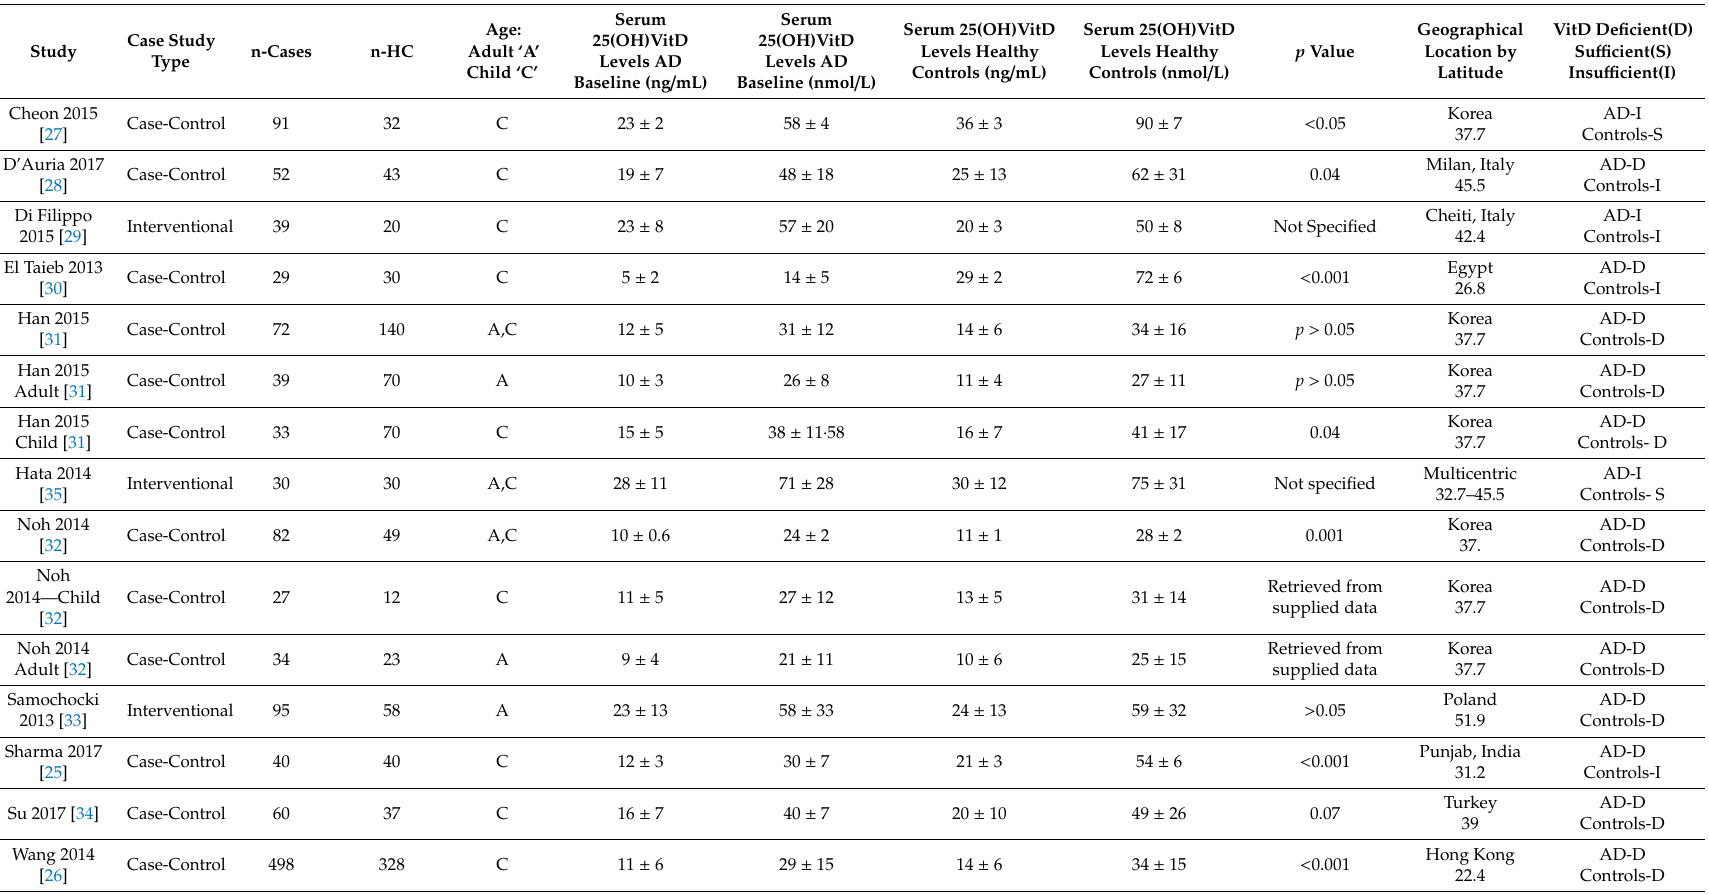
Table 2. Showing data of serum 25(0H)D levels in the atopic dermatitis participants compared to healthy controls in included studies.